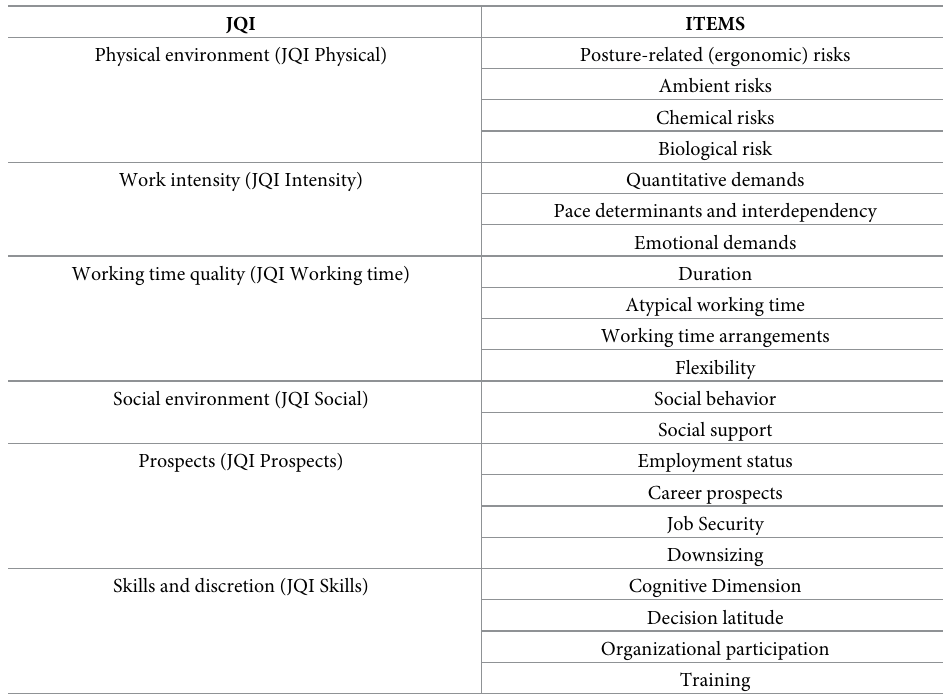
Table 1. Variable’s description.